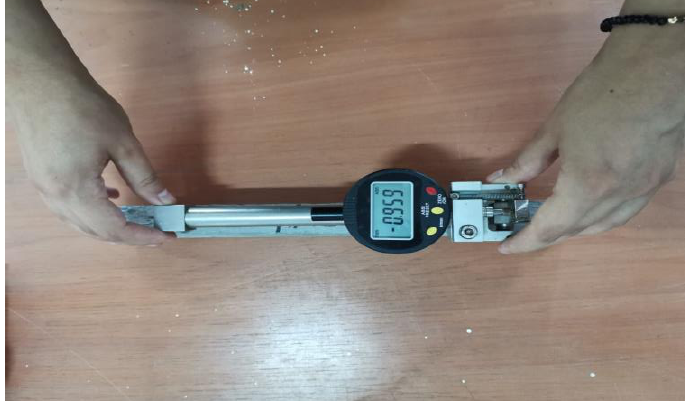
Figure 3. Dial gauge.